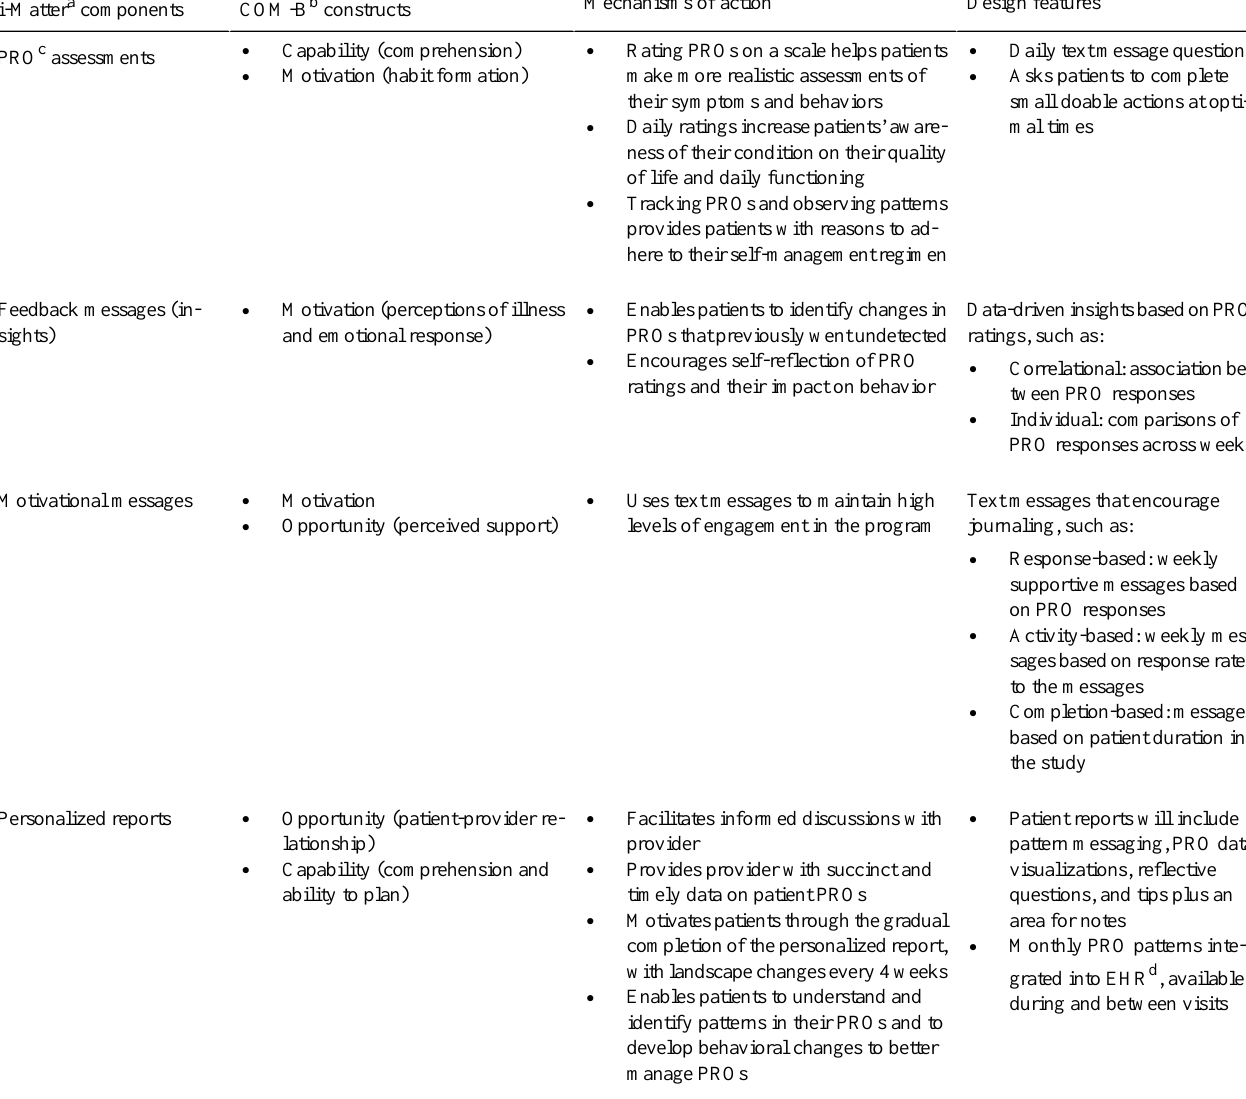
Design featuresMechanisms of actionCOM-B b constructsi-Matter a